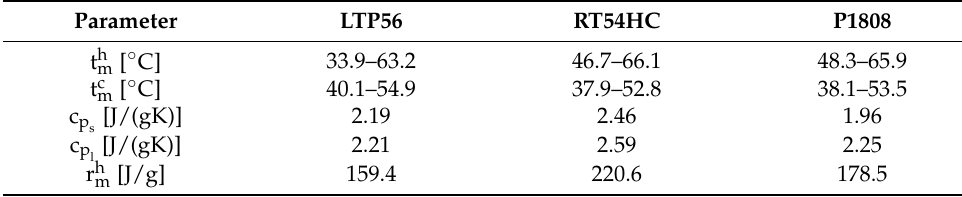
Table 3. DSC characteristics of the tested